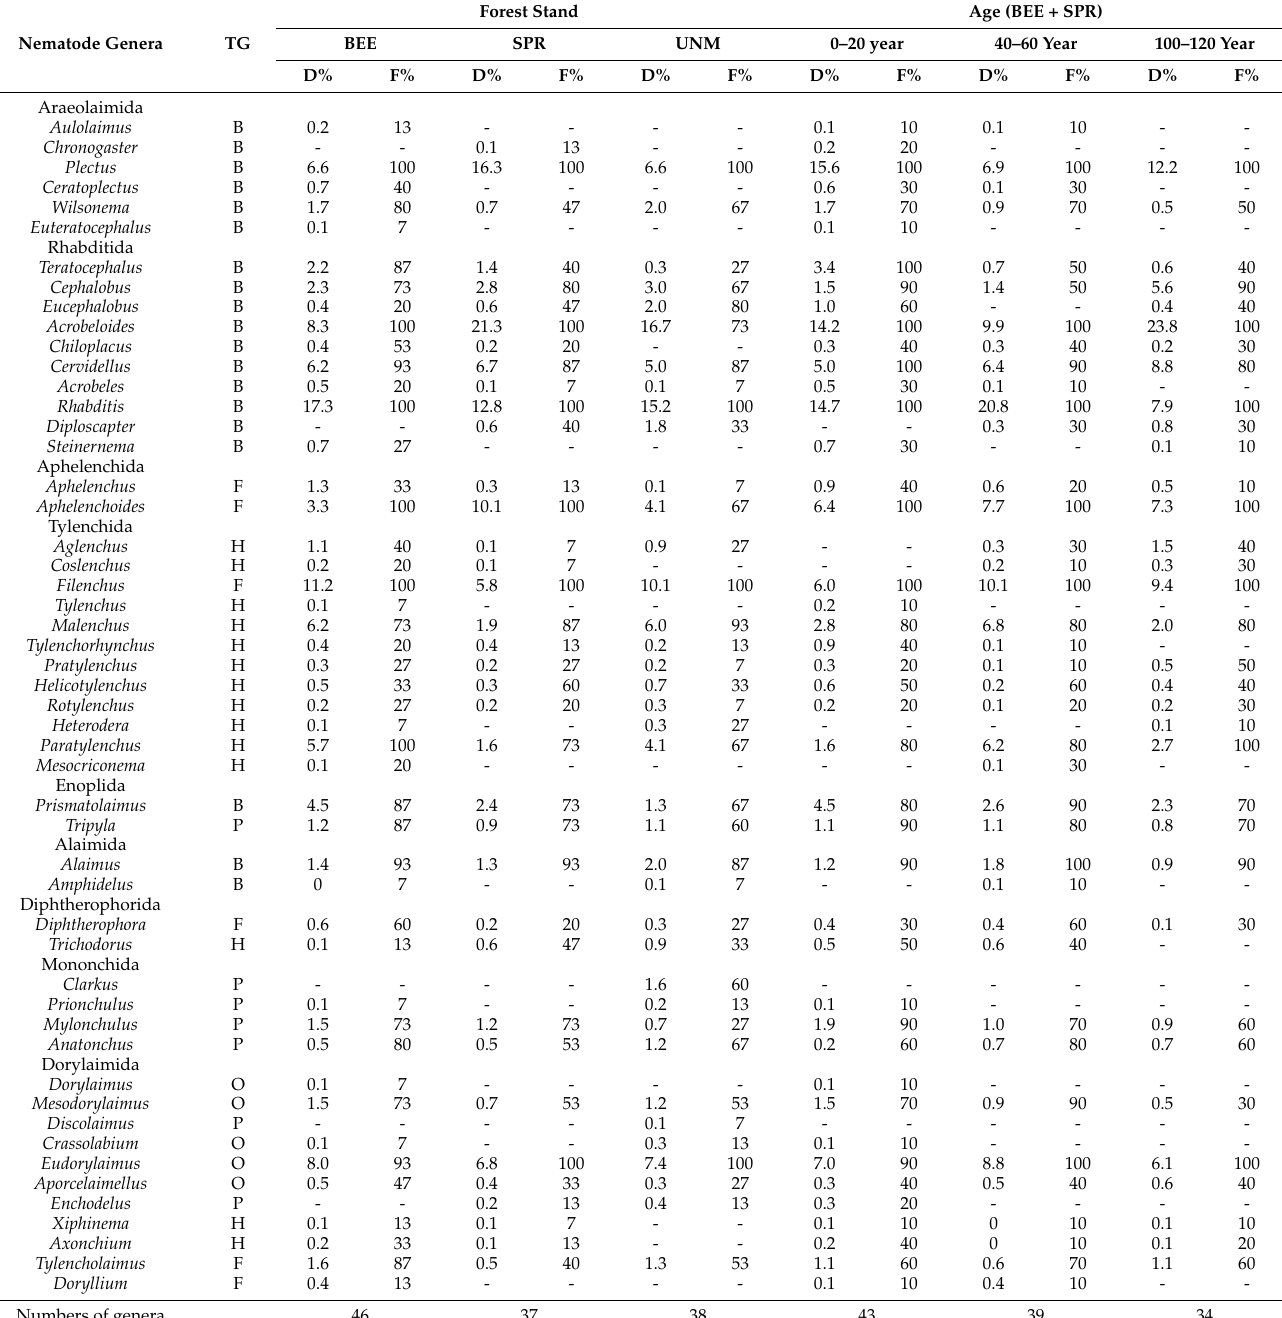
Table 2. List of identified nematode genera, their dominance D%, and frequency of occurrence F% at three forests: BEE—European beech Fagus sylvatica L.; SPR—Norway spruce Picea abies (L.) H. Karst.; UNM—unmanaged old-growth forest, and at three